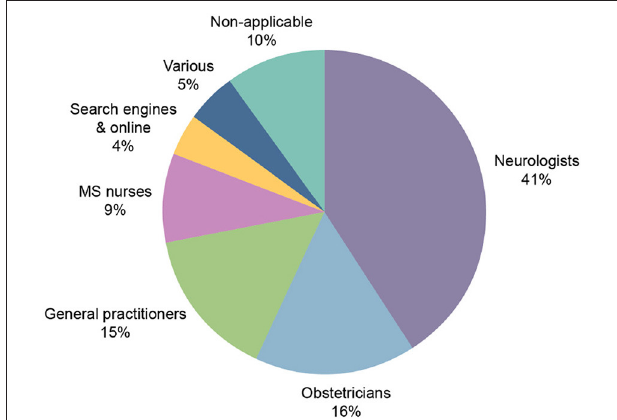
FIGURE 5 | Primary sources of information on family planning. MS, multiple sclerosis.